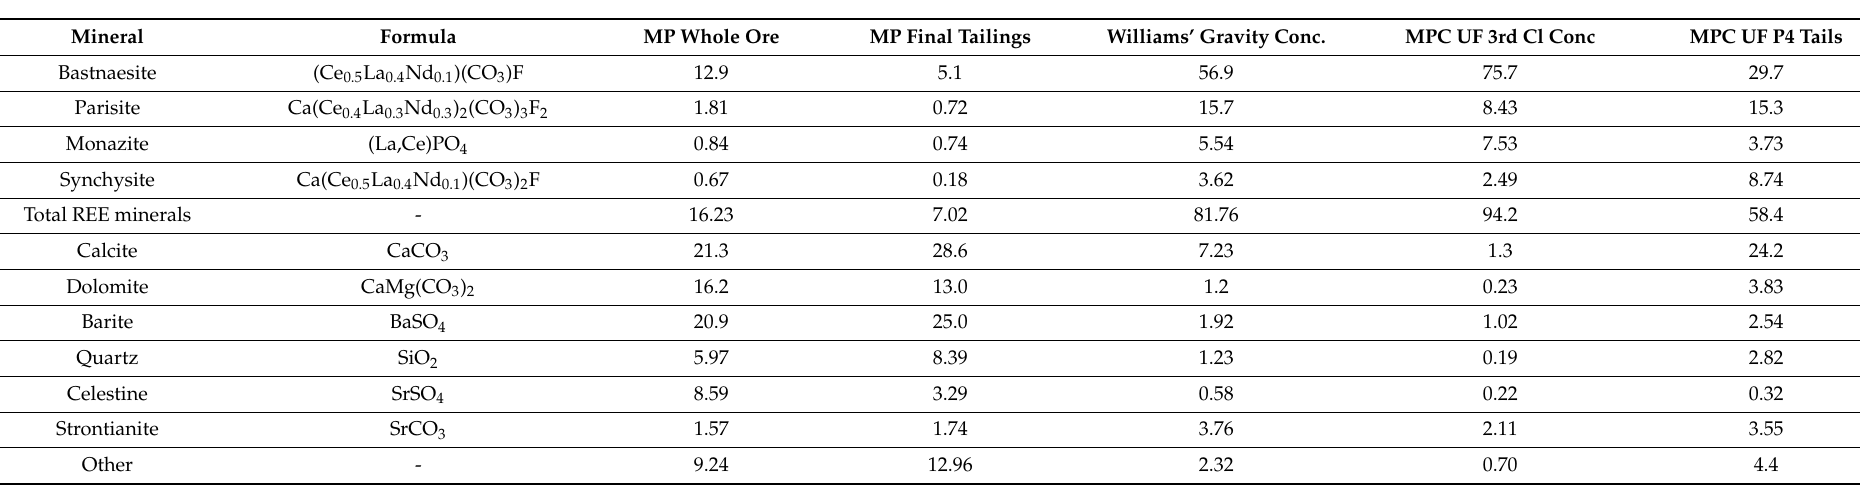
Table 2. Modal mineral content for the Mountain Pass whole ore and final tailings samples and selected subsequent materials generated via UF Falcon gravity